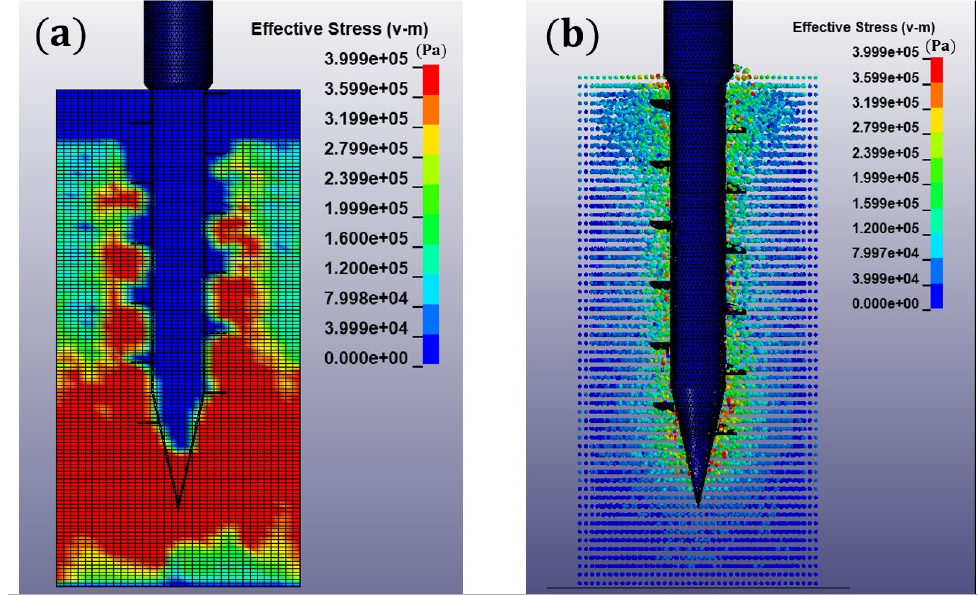
Figure 12. The variation in soil stresses around the screw pile: ( a ) FEM and ( b ) FEM-SPH.